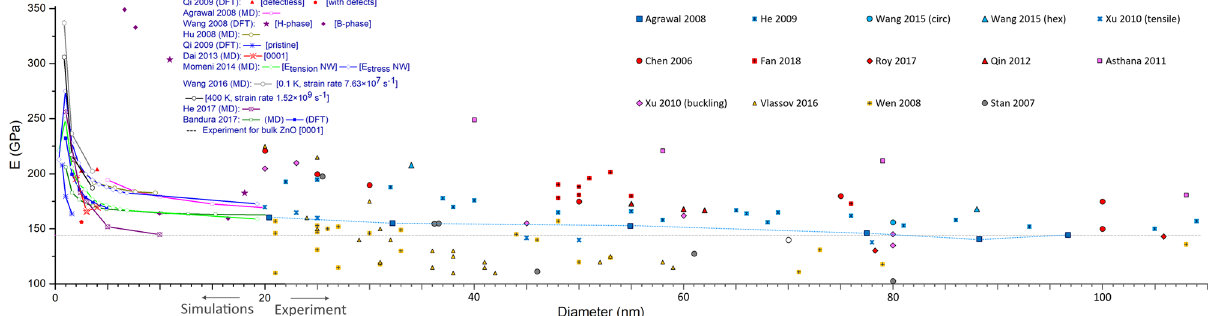
Figure 11: Combined data for the dependence of Young ’ s moduli on NW diameters reported by di ff erent authors in simulations ( left ) and experiment ( right ) . Dashed gray line corresponds to experimentally measured elastic modulus of bulk ZnO crystal. Dotted blue line connects data points reported by Agrawal et al. [ 36 ]